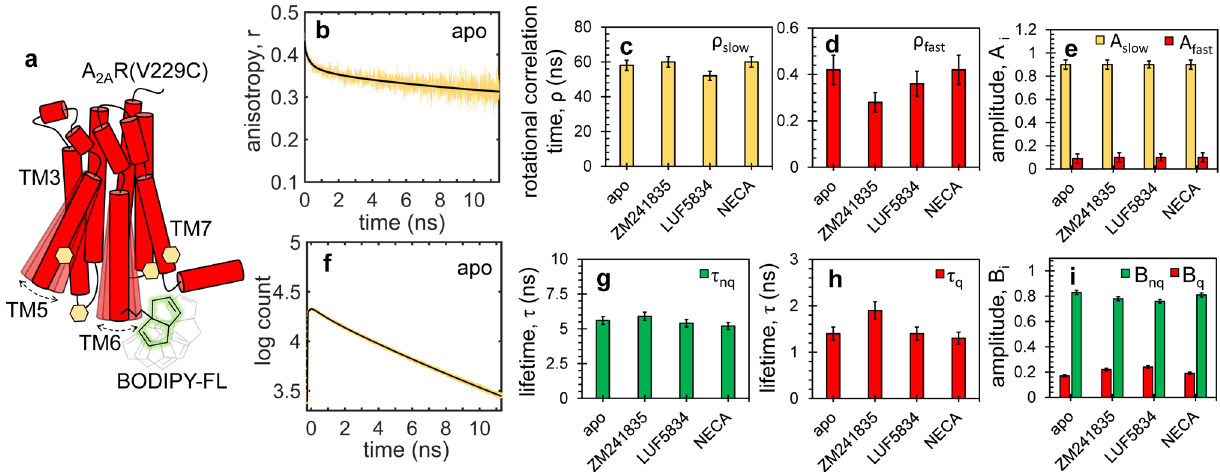
Figure 2. Rotational freedom and quenching of BODIPY-FL in A 2A R. ( a ) Native aromatic residues (yellow hexagons) on TM3, TM5, and TM7 provide a dynamic quenching environment for BODIPY-FL (green) attached to residue 229 6.31 in A 2A R(V229C 6.31 ). Fluorescence anisotropy ( b ) and lifetime ( f ) decay curves for apo A 2A R (yellow) were fitted to multi-exponential functions, i.e. Eqs. 3b and 4, respectively (black). Similar data was acquired under excess (100 μM) of ligands, i.e. inverse agonist ZM241385, partial agonist LUF5834 and full agonist NECA, and was fitted to the same models. Slow and fast rotational correlation times for all ligand conditions shown as yellow and red bars in ( c ) and ( d ), respectively, and their corresponding amplitudes in ( e ). Unquenched and quenched fluorescence lifetimes shown as green and red bars in ( g ) and ( h ), respectively, and their corresponding amplitudes in ( i ). Standard deviations shown in ( c – e ) and ( g – i ) were estimated by parametric bootstrapping. The experiments were performed on 100 nM solutions of labelled receptors using pulsed 480-nm laser excitation. The fitting results are shown in Table 2 (anisotropy) and Table 3 (lifetime).